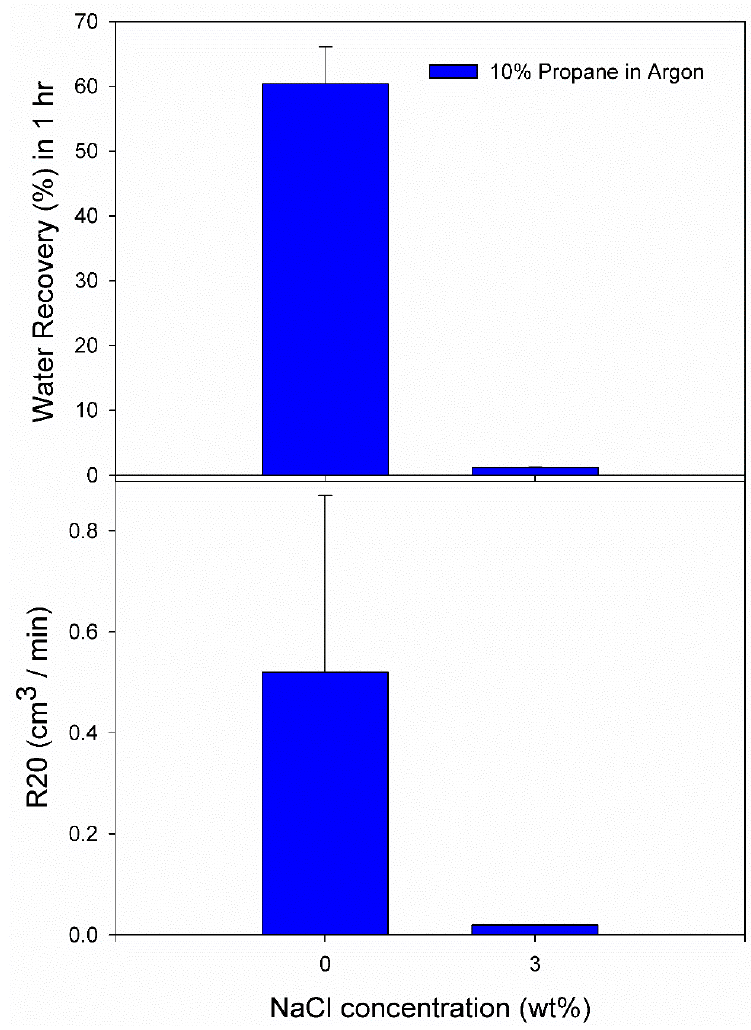
Figure 5. Effect of NaCl concentration on water recovery for the 10% propane in argon gas mixture.